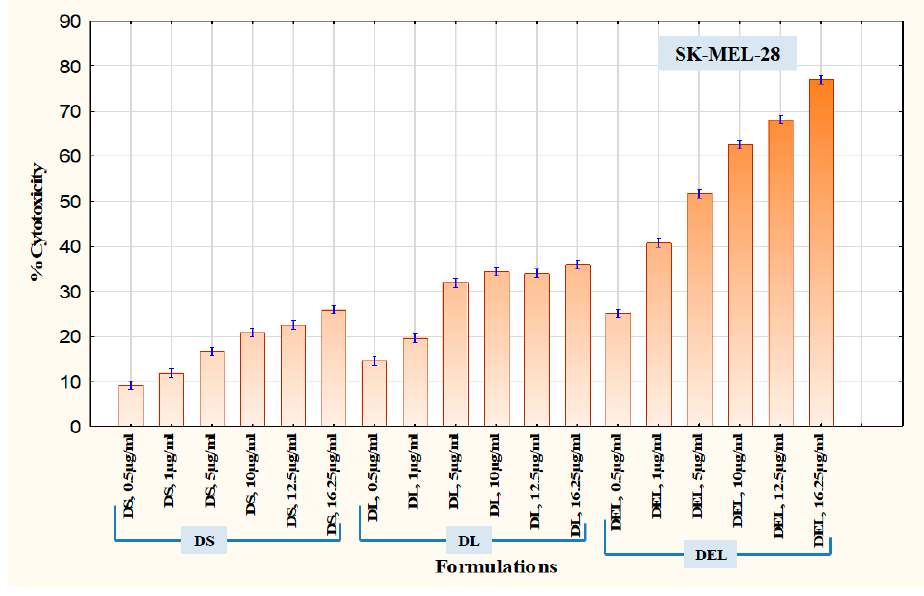
Figure 12. Cytotoxicity in SK-MEL-28 Melanoma Cells.